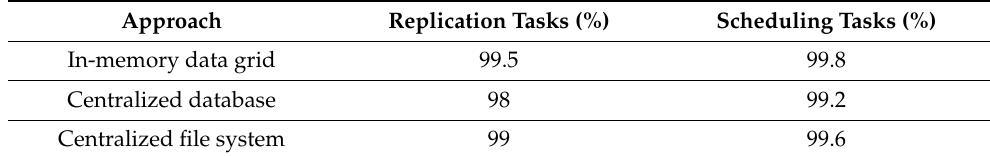
Table 8. Success rate results.